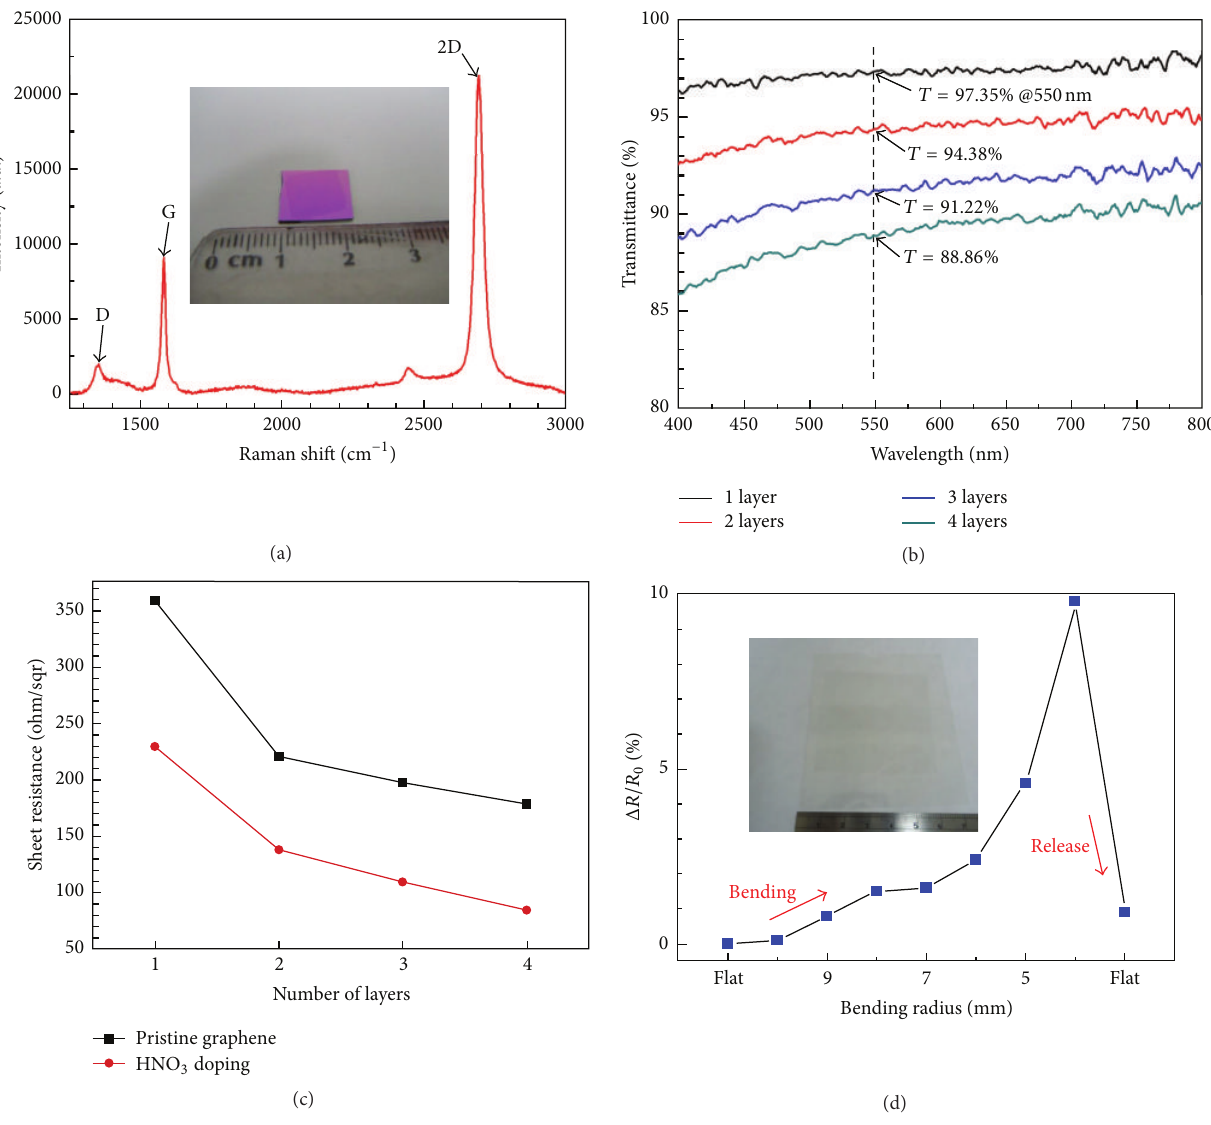
Figure 4: (a) Raman spectrum of monolayer graphene on the SiO 2 (300nm)/Si wafer (inserted image). The 2D/G ratio is about ∼ 2.6, and the FWHM of the 2D peak is 28.5 cm −1 . A small D/G peak ratio of 0.22 was introduced during the transfer process. (b) Transmittance of stacked graphene films at 𝜆 = 550 nm as a function of the number of stacked graphene layers. (c) Sheet resistance of stacked graphene films as a function of the number of stacked graphene layers before and after being doped by HNO 3 . (d) Variation in the electrical resistance of the graphene film for a bending radius from 10mm to 4